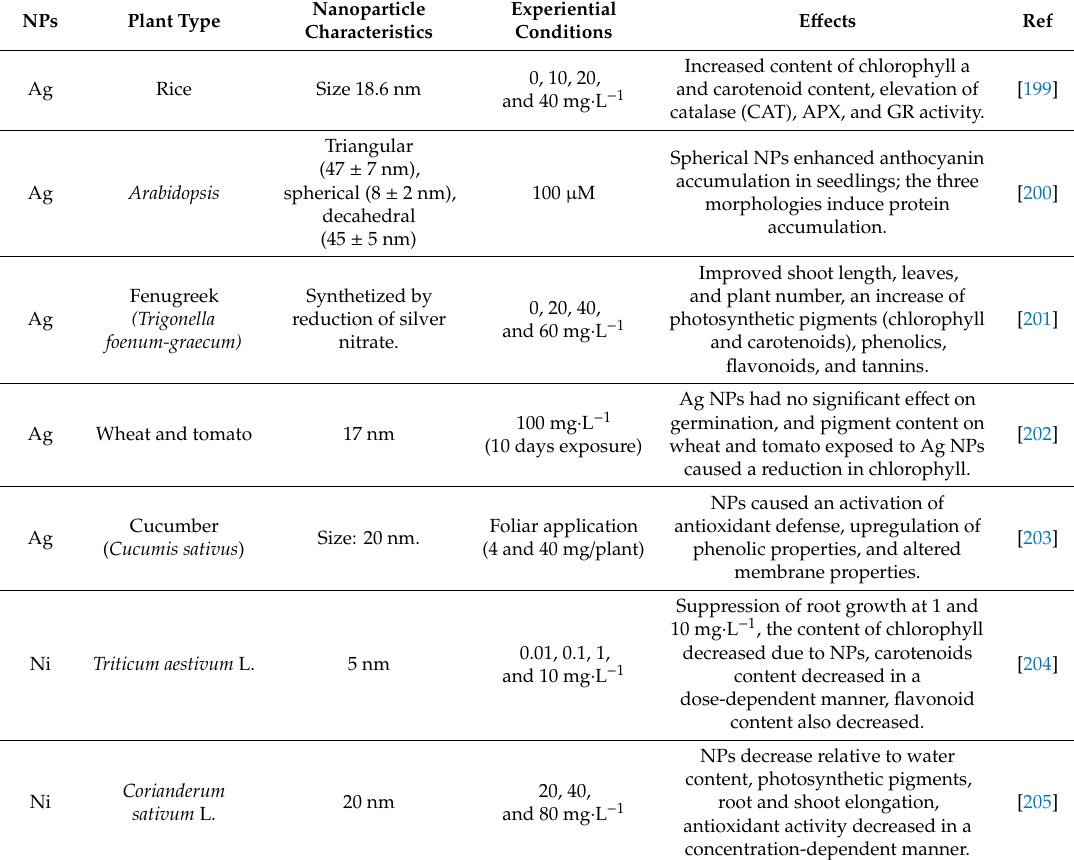
Table 5. Multiple findings toward metabolomics e ff ects in plant due to metallic NPs